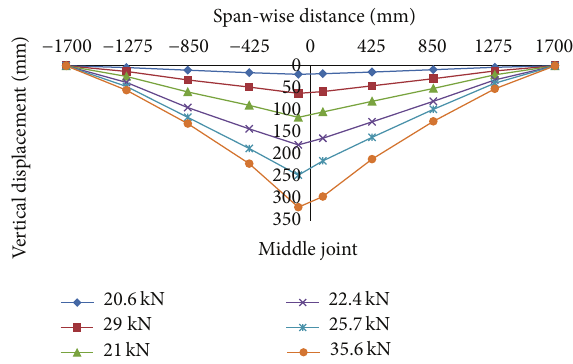
Figure 12: Deflection profiles of specimen corresponding to indi- cated